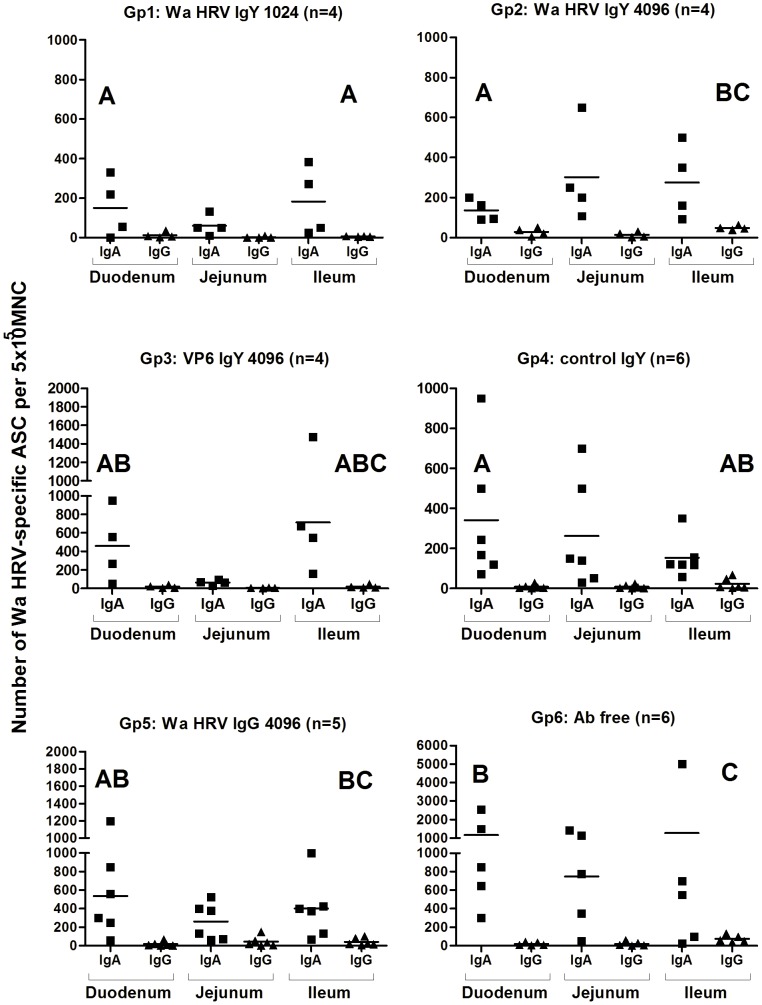
Numbers of Wa HRV-specific ASC per 5×105 MNC obtained from gut-associated lymphoid tissues (Duodenum, Jejunum, Ileum) at 21 PID.For each tissue, when comparing ASC numbers of the same isotype among treatment groups different letter indicate a significant difference (Kruskal-Wallis rank sum test, p<0.05). n = number of piglets in each group. The IgM ASC response was not included as no IgM ASC were detected in most of the groups of pigs.